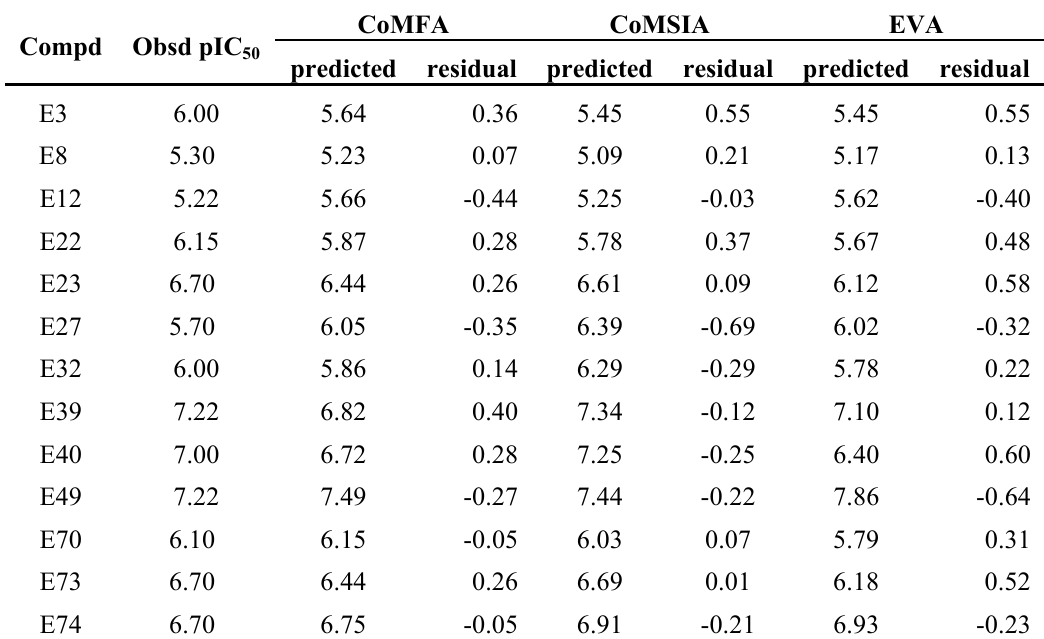
Table 2. Experimental and predicted values for the test